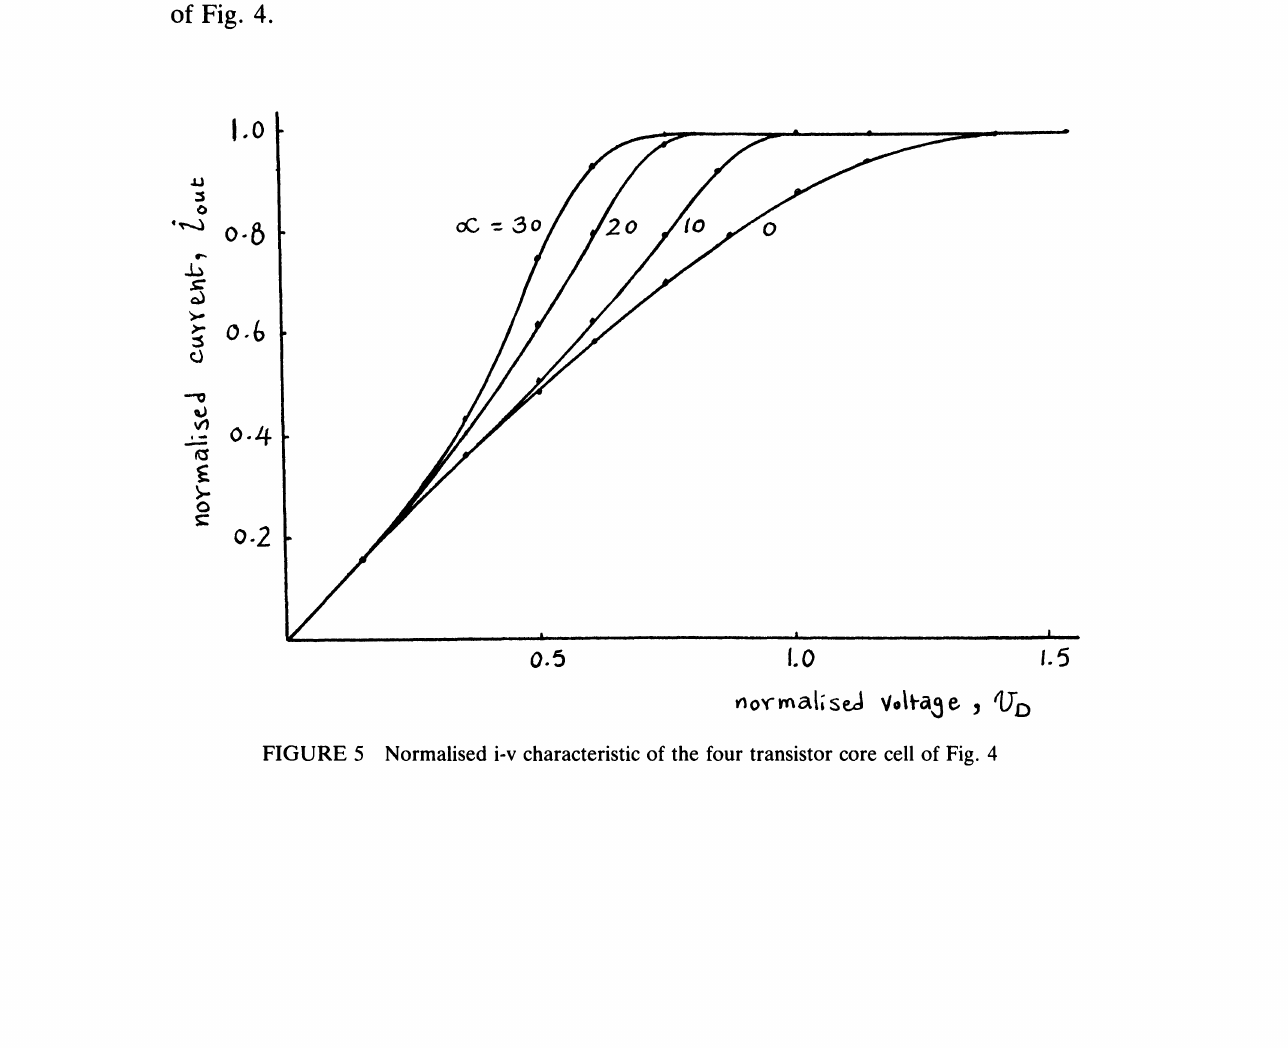
FIGURE 5 Normalised i-v characteristic of the four transistor core cell of Fig.